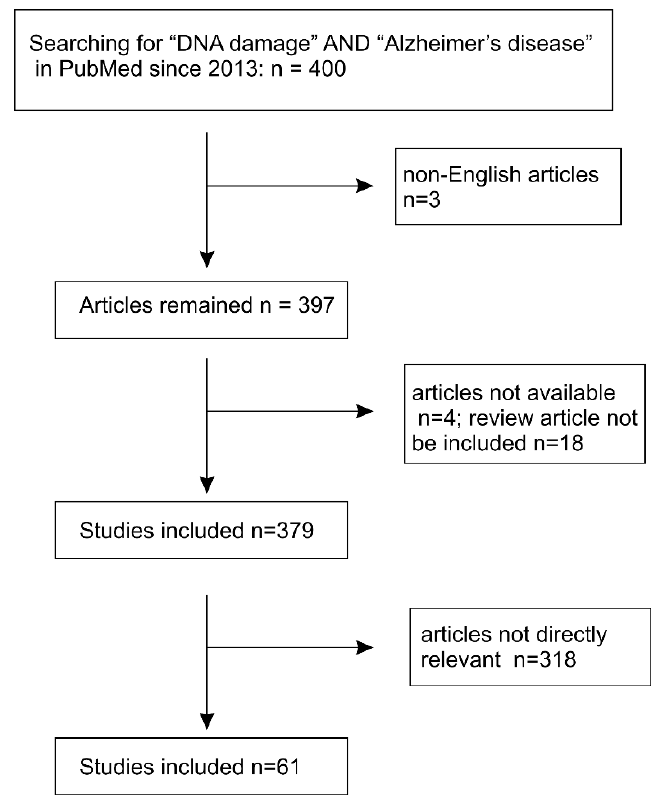
Figure 1. Systemic literature search and selection of articles for review.